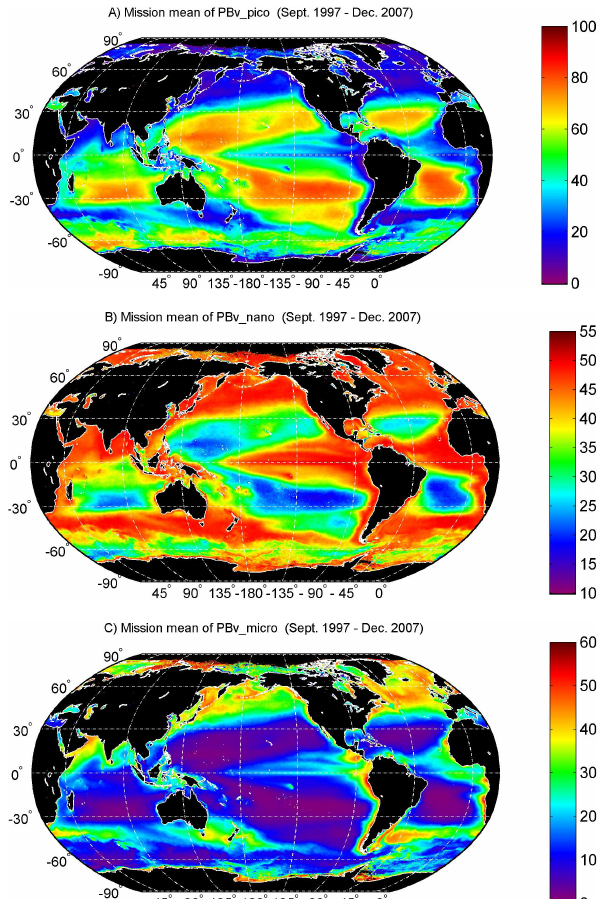
Fig. 6. SeaWiFS mission mean (Sep 1997–Dec 2007) maps of the PFT’s: (A) the percent volume concentration contribution of picoplankton-sized particles (0.5–2µm in diameter), (B) the percent volume concentration contribution of nanoplankton-sized particles (2–20µm), and (C) percent volume concentration contribution of microplankton-sized particles (20–50µm). The percent contribu- tions were calculated out of the total volume (0.5–50µm diameter range) as a function of the PSD slope ξ (Eq. 2; Fig.